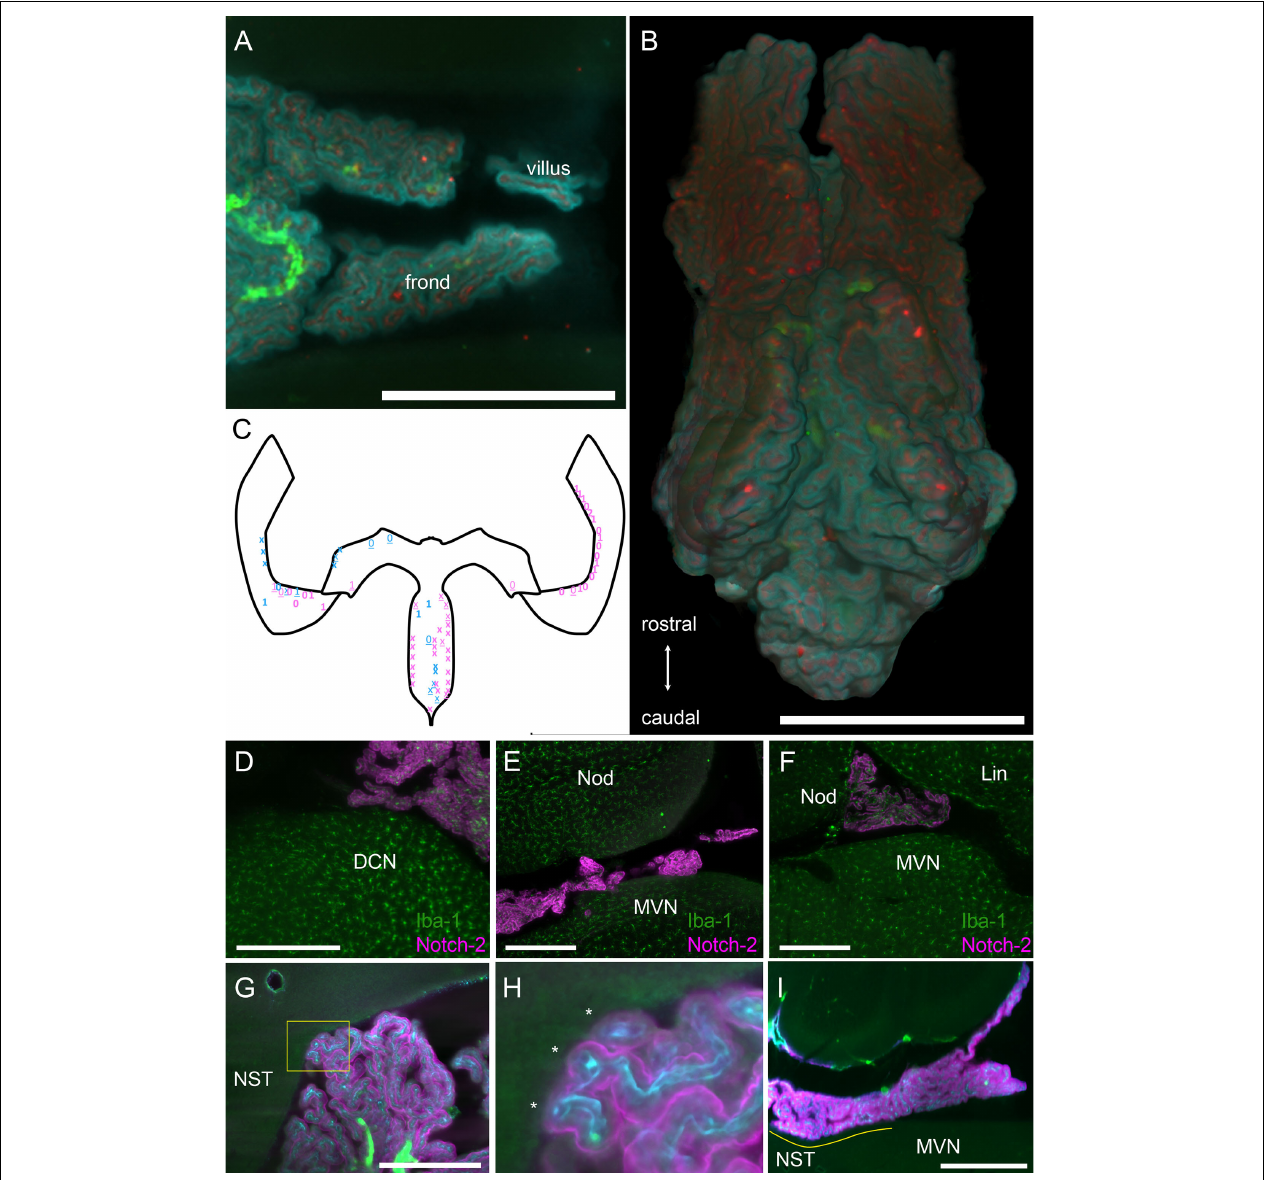
FIGURE 3 | Structure of hCP fronds and villi. (A) Example of frond and villus from the CSS. Z-stack maximal projection over 50 µ m z-range (5 µ m steps, 10 planes). Cyan, Notch-2; red, ColIV; green, autofluorescence and SMA. Scale bar: 1 mm. (B) Three-dimensional rendering of the ventral view of the whole SS segmented from the same sample in (A) . Scale bar: 1 mm. (C) Schema of the CP as in Figure 1A , with indications of location and approximate size of contacts (each symbol indicates a single villus). Blue, males; pink, females. Numbers indicate macrophages at contact site for two animals. Xs indicate two different animals where macrophages were not labeled. Bold symbols indicate tight contacts, underlined symbols indicate loose contacts. In female samples, one was without bone, so only HS was considered, whereas the other was cut in half sagittally, so only HS was considered. In both male samples, right HS was damaged and was not considered. (D) Example of foot contacting the DCN. Z-stack maximal projection over 60 µ m z-range (2 µ m steps). Green, Iba-1 labeling; magenta, Notch-2. (E) Foot contacting the MVN. Z-stack maximal projection over 60 µ m z-range (2 µ m steps). Green, Iba-1 labeling; magenta, Notch-2. (F) Foot contacting the lingula. Single 2 µ m optical slice. Green, Iba-1 labeling; magenta, Notch-2. Scale bar for (D–F) : 400 µ m. (G) Foot contacting the nucleus of the solitary tract. Single 3 µ m optical slice. Green, autofluorescence and SMA; cyan, ColIV; magenta, Notch2 labeling. Scale bar: 500 µ m. (H) Magnification of COLM image of the contact shown in G (yellow box). Three fronds (asterisks) each containing a capillary are seen contacting the ependyma. (I) Single sagittal 5 µ m optical plane showing the extent of the largest observed contact area (yellow line). NST, nucleus of the solitary track. Scale bar: 1 mm.